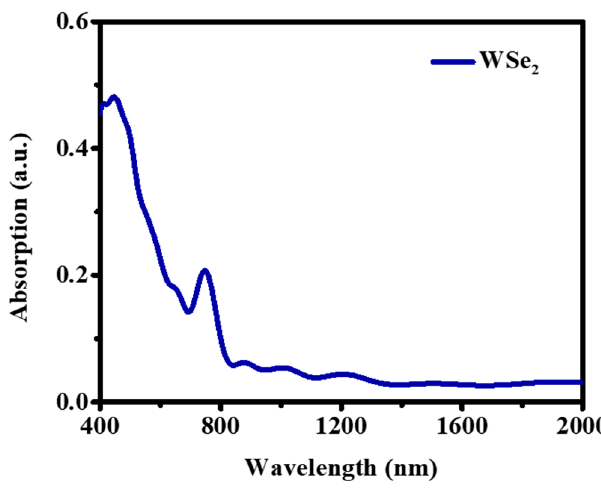
Figure 2. The absorption of few-layer WSe 2 nanosheets.